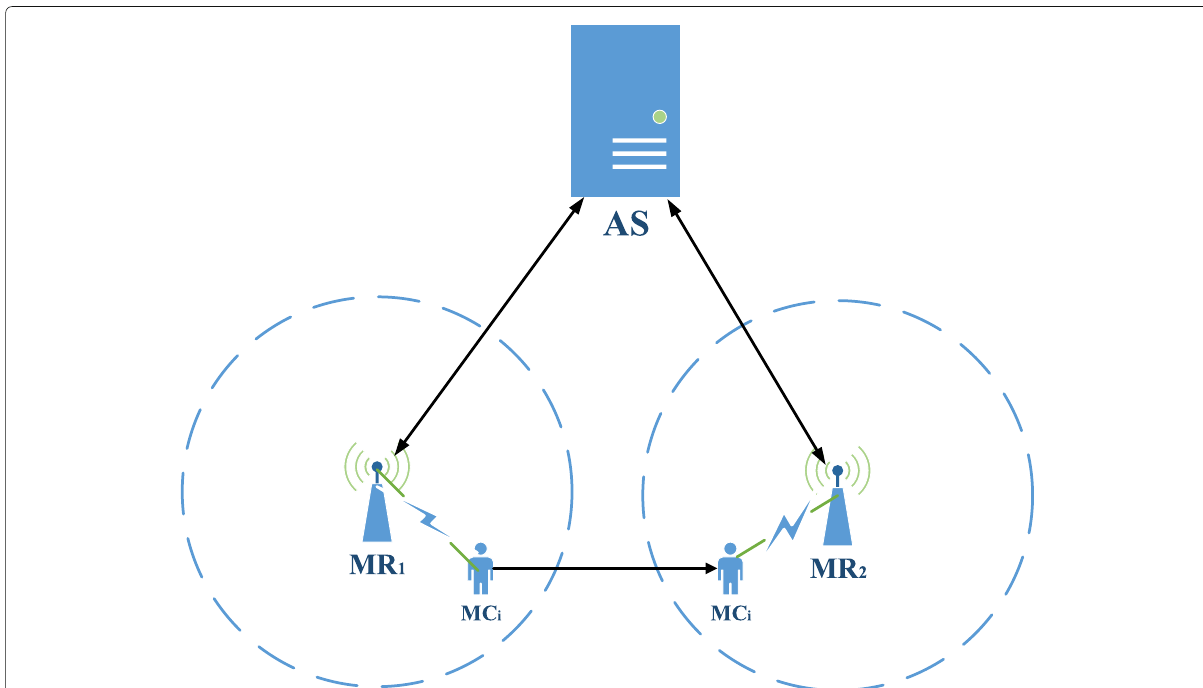
Fig. 1 Typical handover authentication scenario for wireless mesh networks. This figure describes a typical wireless mesh network handover authentication scenario. Three types of entities participate in this scenario, which are mesh clients (MCs), mesh routers (MRs), and an authentication server